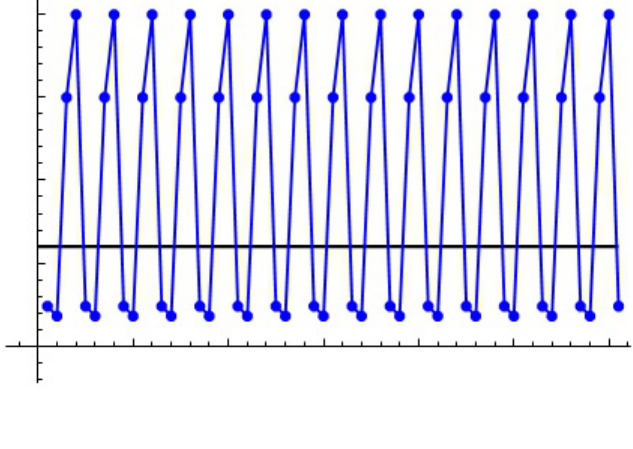
Fig. 2 y n graph